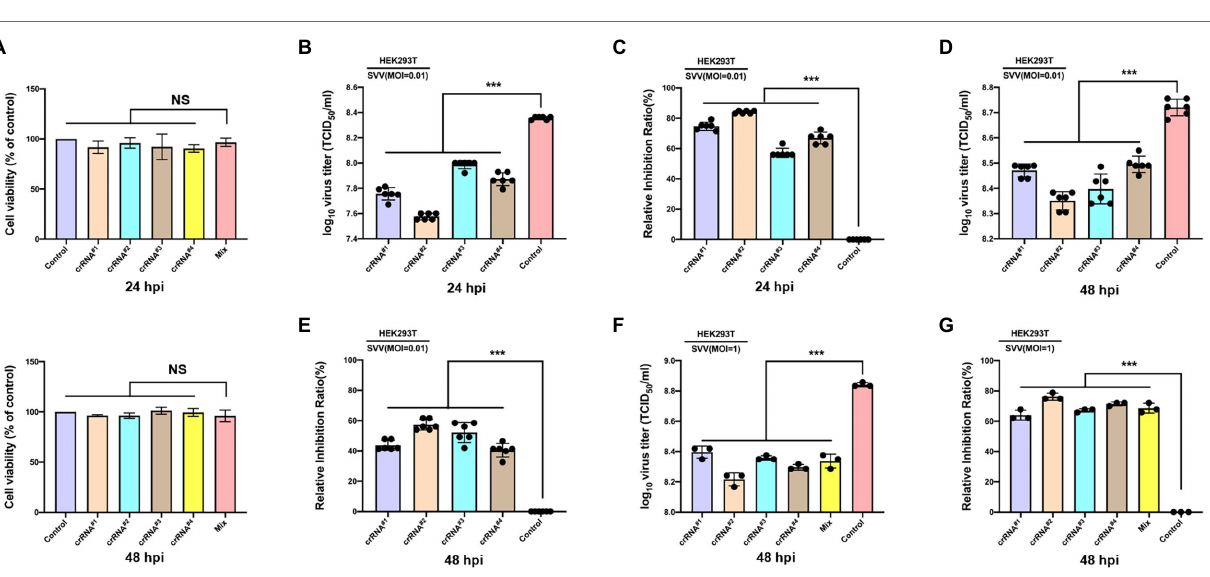
FIGURE 4 | Efficient inhibition of SVV infection via the engineered CRISPR-Cas13d system. (A) HEK-293T cells were cotransfected with Cas13d and the indicated crRNAs plasmid, the cells viability at 24 hpt or 48 hpt was determined. (B) HEK-293T cells were cotransfected with Cas13d and the indicated crRNAs plasmid. Twenty-four hours later, the cells were infected with SVV (at an MOI of 0.01), and viral titers in the cell culture supernatants at 24 hpi or (D) at 48 hpi were determined. (C) The percentage reduction of virus titers was detected in the crRNA groups (#1, #2, #3, and #4) relative to the crRNA control group at 24 hpi or (E) at 48 hpi. (F) HEK-293T cells were cotransfected with Cas13d and the indicated crRNAs plasmid or crRNAs pool. Twenty-four hours later, the cells were infected with SVV (at an MOI of 1), and viral titers in the cell culture supernatants at 48 hpi were determined. (G) The percentage reduction of virus titers was detected in the crRNA groups (#1, #2, #3, #4, and mixed pool) relative to the crRNA control group at 48 hpi. Error bars represent the SD; * p < 0.05, *** p < 0.001.